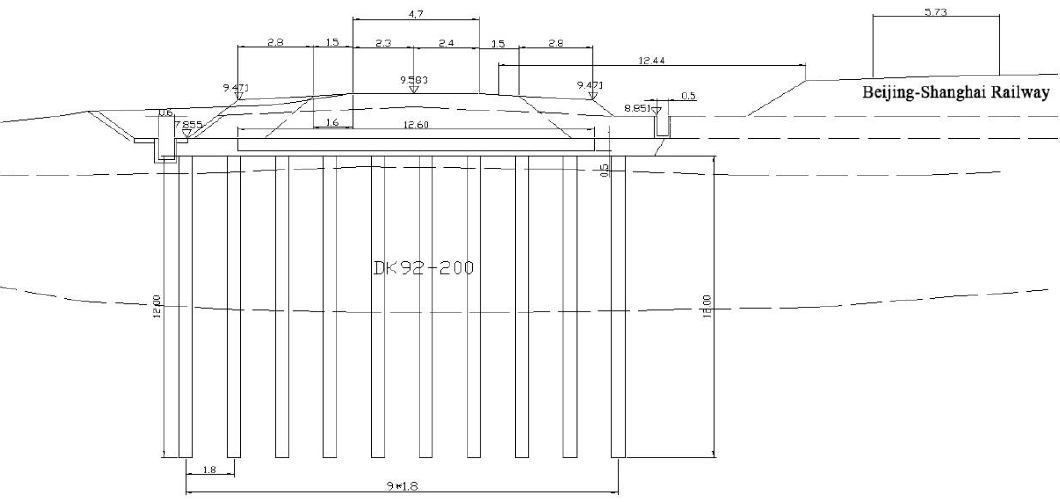
Figure 1. Schematic cross-section of two lines close to the test.